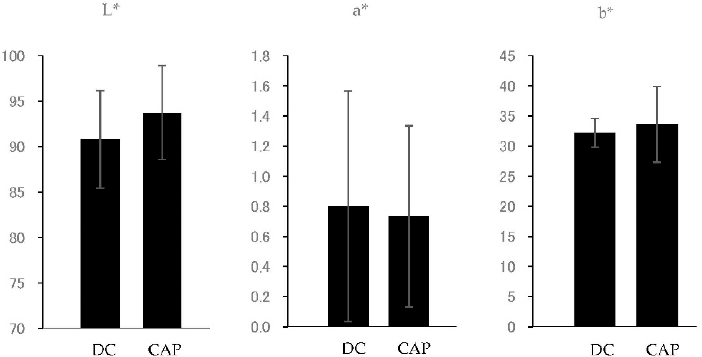
Figure 5. Graphs showing the L*a*b* values. DC, dentin color; CAP, CAP system treatment. Table 2. Results of the measurement of L*a*b* values.